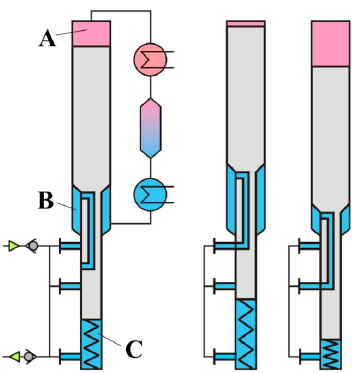
Figure 4. Scheme of Bush-type self-driven machine; A —hot part, B and C —cold parts with the displacer in intermediate ( left ) and two extreme positions.